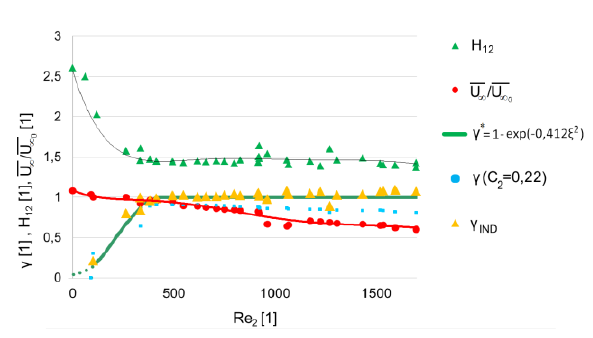
Fig. 9. (Re 2 ), H 12 (Re 2 ), γ (Re 2 ), γ(Re 2 ) IND , / UU  0 γ * (Re 2 ), α = 5°, rough (P32) surface of flat plate, Iu e = 0,5%